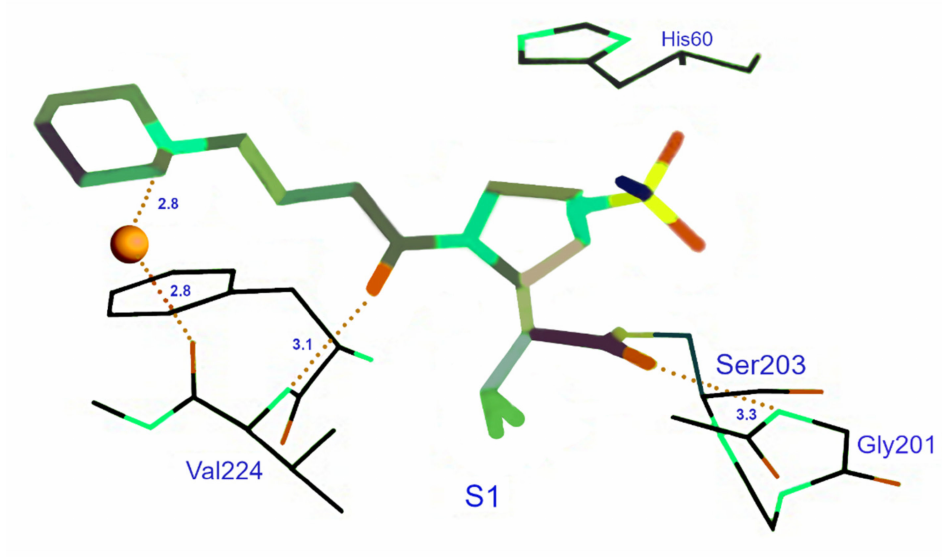
Figure 3. Crystal structure of GW-311616 complexed with porcine pancreatic